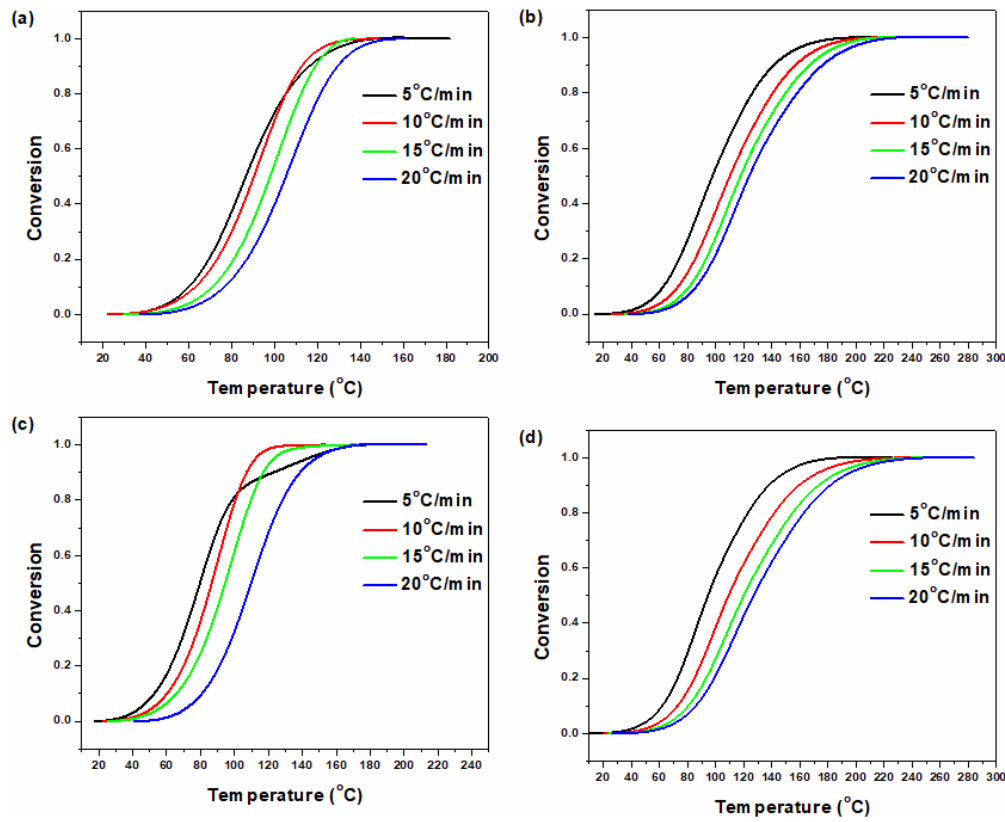
Figure 2. Fractional extent of conversion for neat epoxy and its nanocomposites at heating rates of ( a ) 5, ( b ) 10, ( c ) 15 and ( d ) 20 °C min −1 .